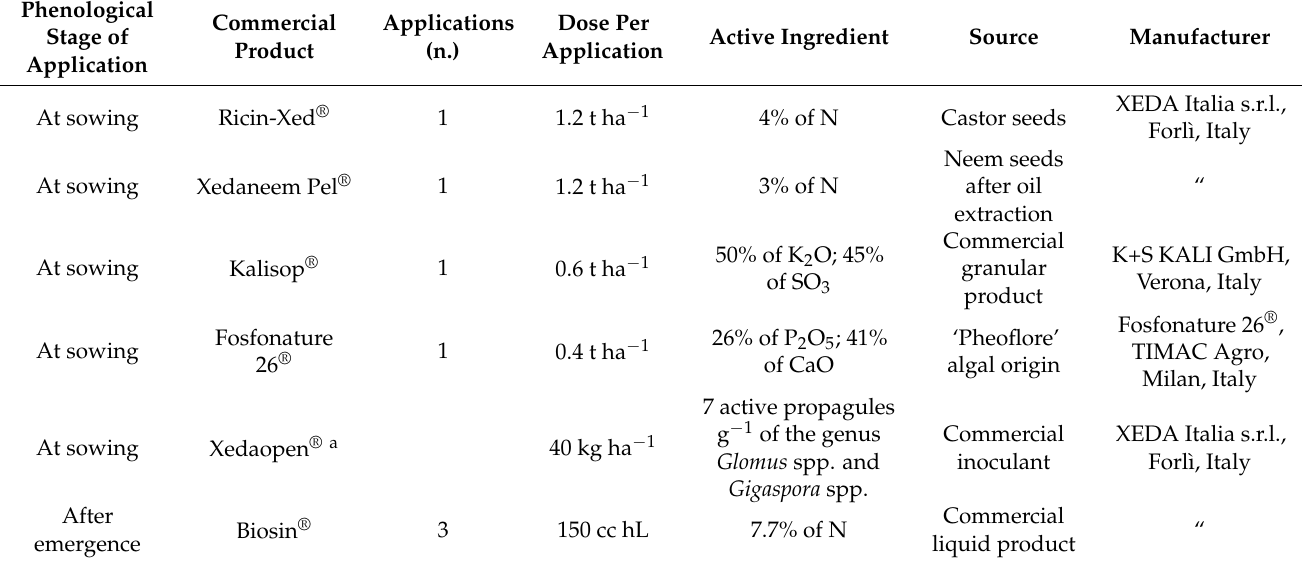
Table 2. Fertilization and mycorrhizal management of potato crop organically